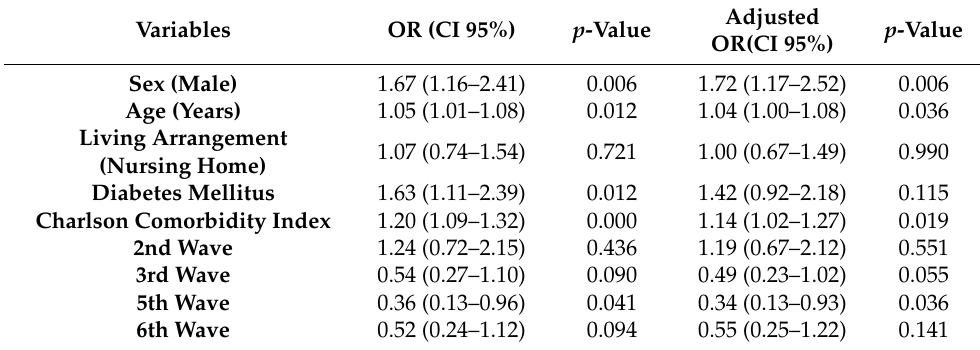
Table 4. Risk factors associated with COVID-19 mortality. Multivariate analysis.